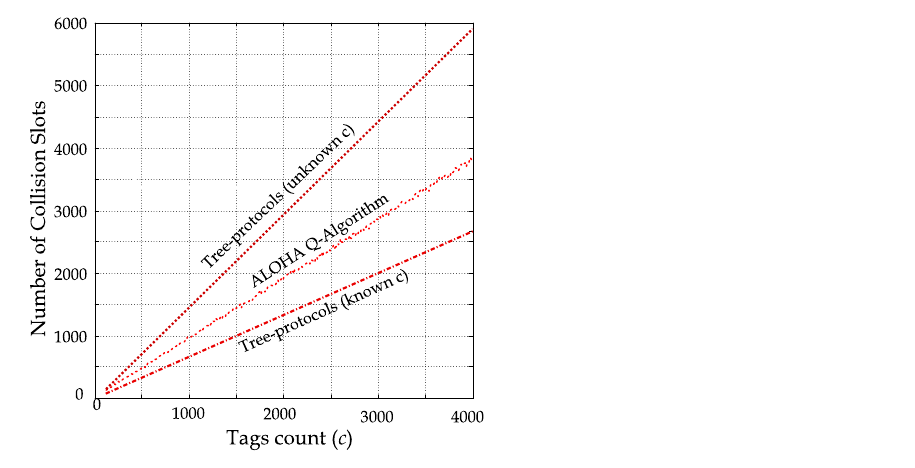
Figure 10. Total number of collision slots vs. different tag populations (from 100 to 4000 tags).